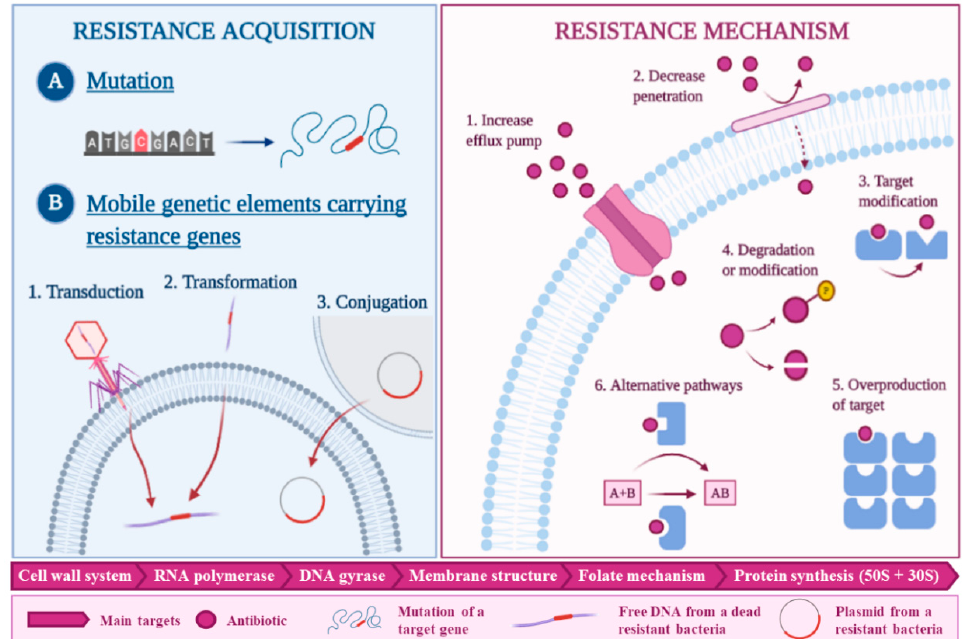
Figure 1. Summary of the resistance acquisition pathways: Mutation and mobile genetic elements: By transduction, transformation or conjugation. Schema of the six main mechanisms of antibiotics resistance. Modified from [1,26,27].